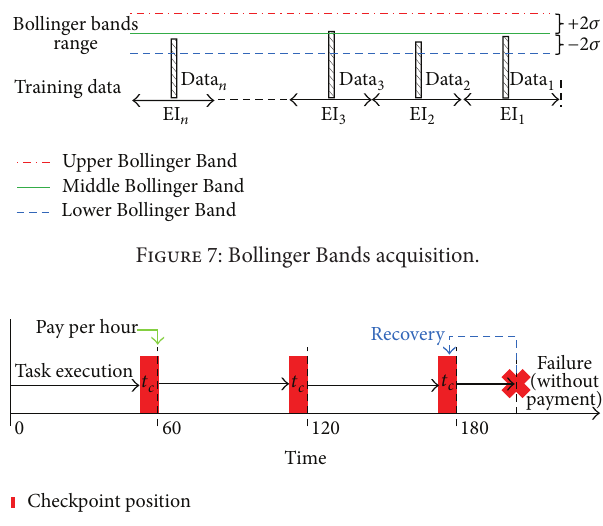
Figure 8: Hour-boundary